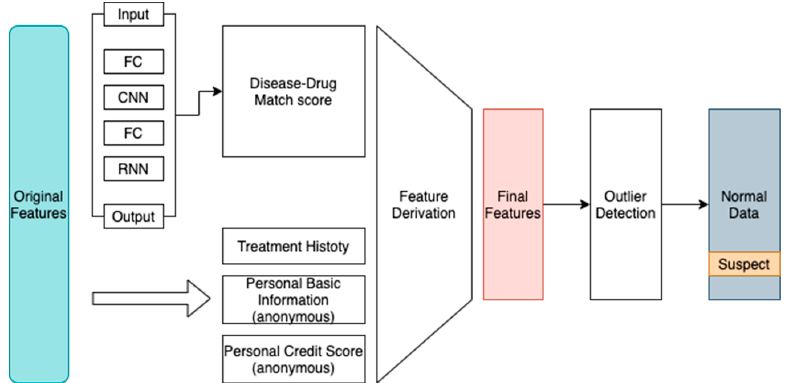
Figure 3. System Diagram.